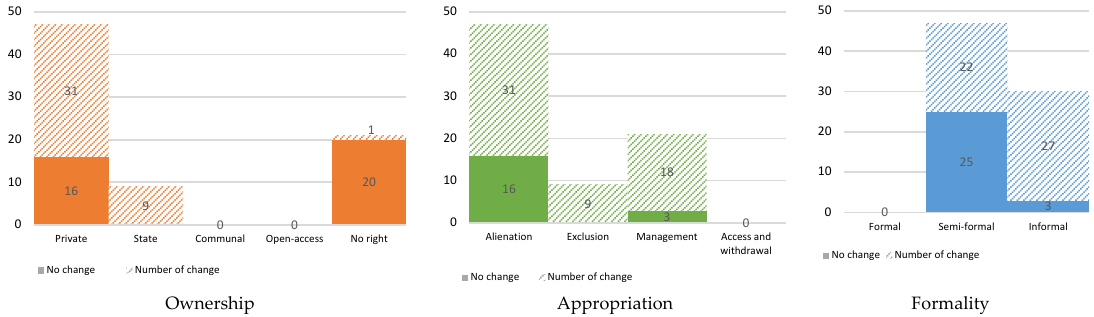
Figure 8. The number of property rights transformation on cultivated lands in KBP.